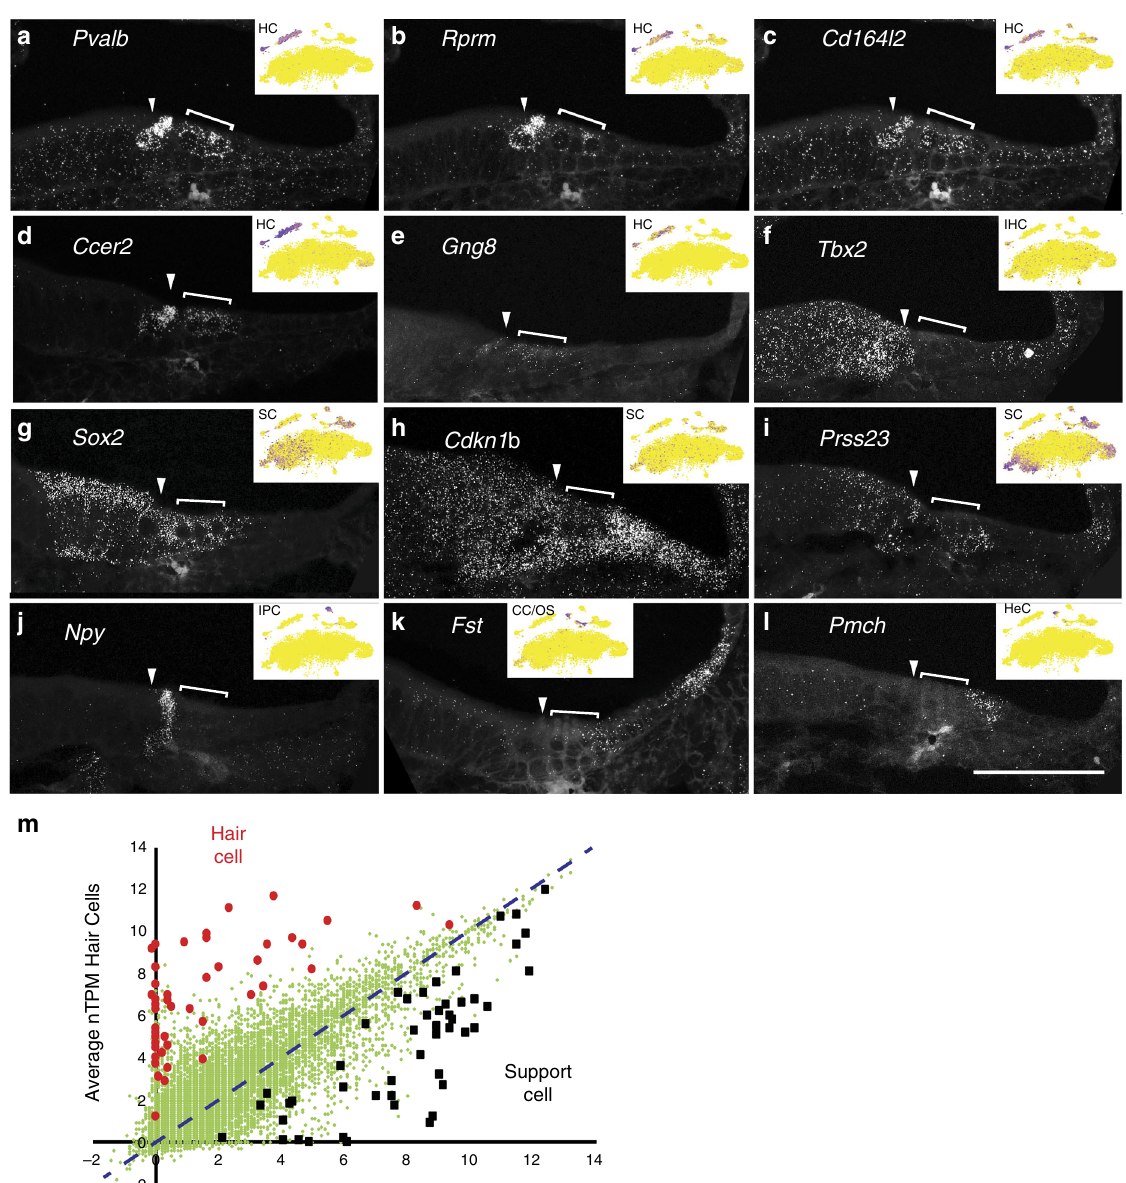
Fig. 2 Validation of cell-type-speci fi c markers at P1. a – l In situ hybridization in P1 cochlear cross sections using smFISH. HCs are localized based on expression of Pvalb . Inset: feature plot for each gene in the P1 t SNE (high expression is indicated in blue). For all panels, the IHC is indicated with an arrow and the three OHCs are indicated by a bracket. HC markers Rprm b , Cd164l2 c , Ccer2 d , and Gng8 e , are all restricted to HCs. Tbx2 f , which was found only in the IHC cluster, is actually expressed in both IHCs and parts of KO. Sox2 g and Cdkn1b h , markers of SCs, are not expressed in HCs but are expressed in surrounding cells. Prss23 i shows a similar localization to cells surrounding the HCs. Npy j is only expressed in pillar cells located between the IHC and the fi rst OHC. Fst k is localized in cells lateral to the OC and Pmch l is speci fi c for Hensen ’ s cells located just adjacent to the third OHC. m Scatter plot comparing differential gene expression for P1 HCs and lateral SCs (see Methods section) with the results from Burns et al. 4 . Green diamonds indicate average nTPM counts for HCs versus SCs in Burns et al. 4 . Red circles indicate the values for the top 50 DE HC genes, and black squares indicate the values for top 50 DE SC genes from this study. See Supplementary Data 3 for a full list of gene names and values. Note that all P1 DE HC genes were more highly expressed in HC from Burns et al. 4 as well. Six P1 DE HC genes and three P1 DE SC genes were not detected in either cell type (see Methods section for details and Supplementary Data 3 (Col. AC-AK for full list of gene identities)). Scale bar in l (same in a – k ), 50 μΜ